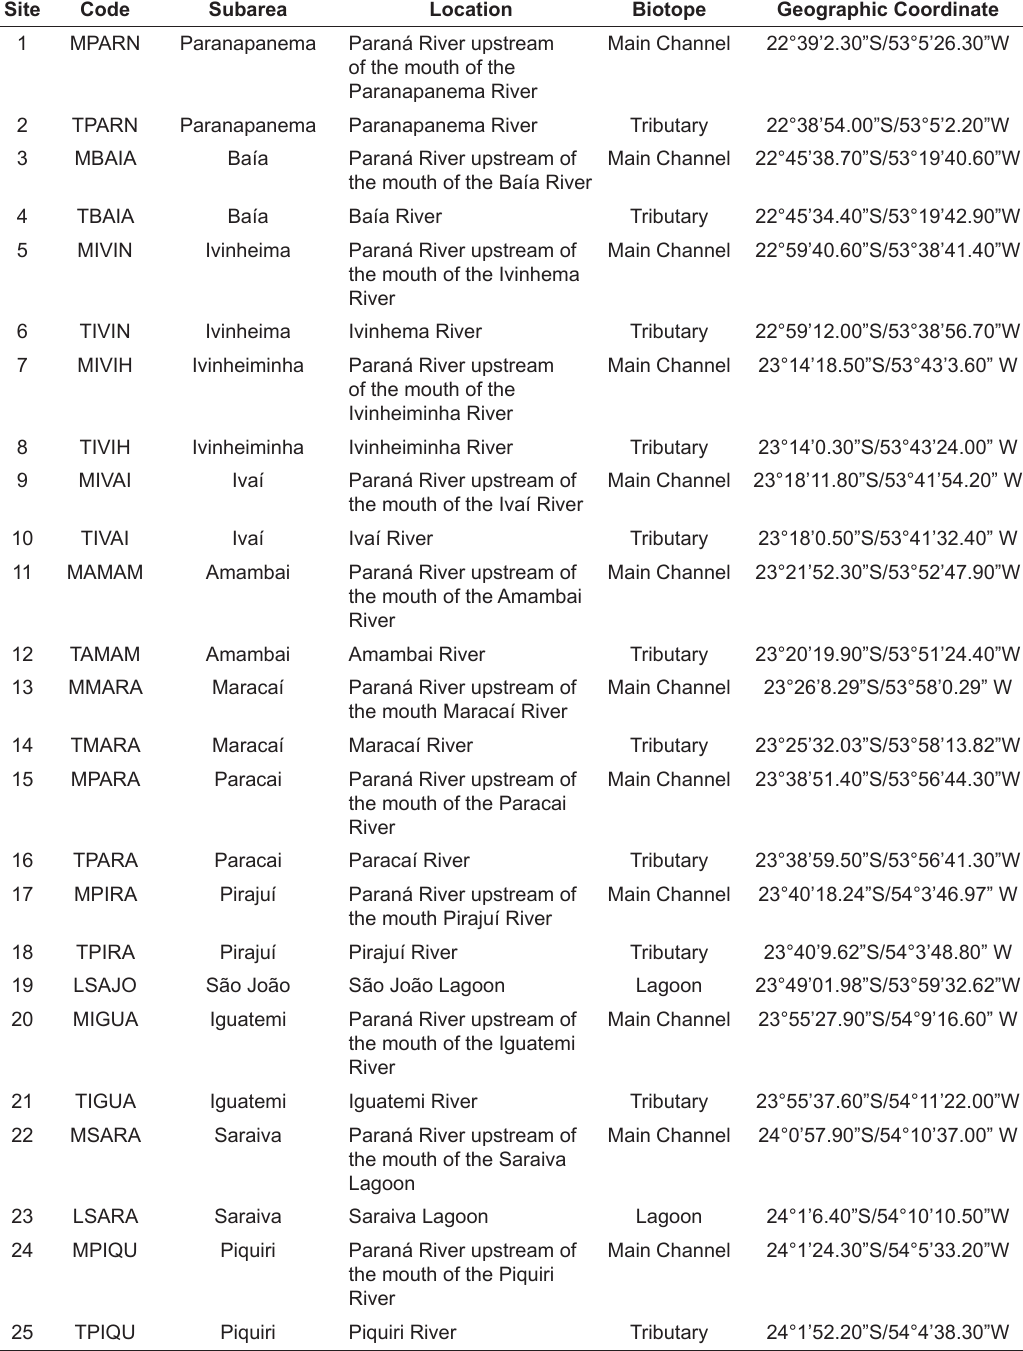
Table 1. Physiographic data of the sampling stations located in the Upper Paraná River floodplain.